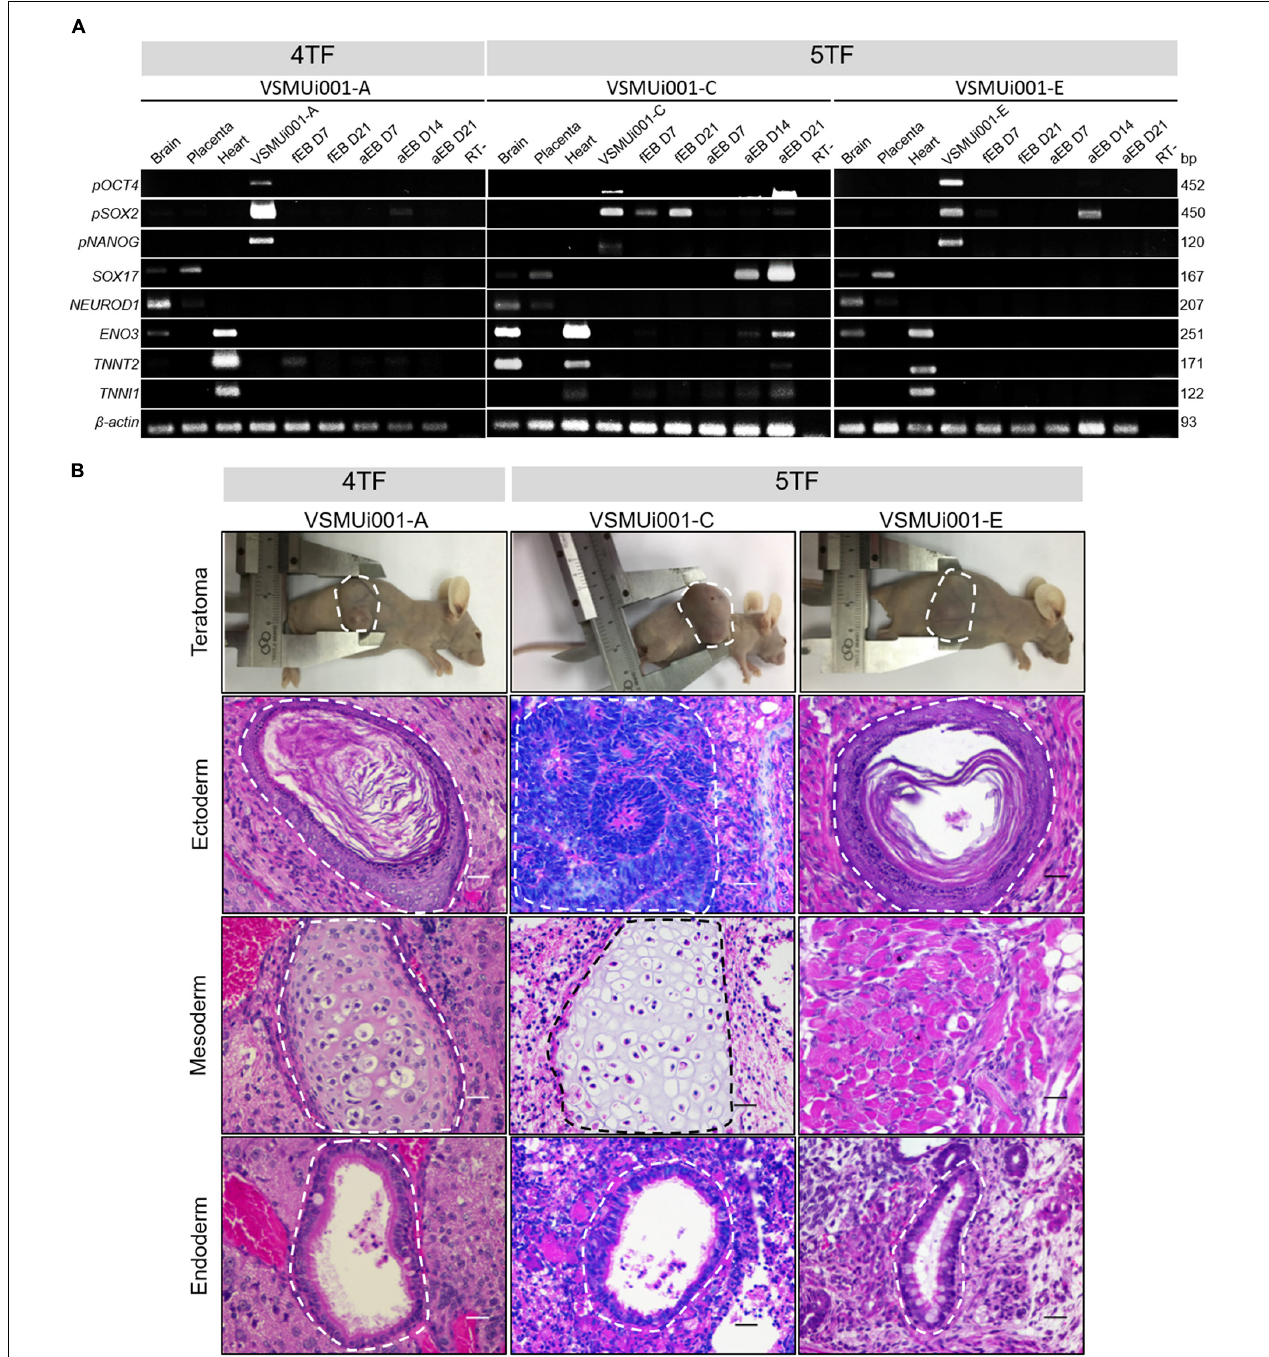
FIGURE 7 | Expression of differentiation-related genes and in vivo differentiation of the various porcine-induced pluripotent stem cell (piPSC) lines. (A) Expression of differentiation genes specific for the three germ layers: pOCT4 , pSOX2 , and pNANOG (pluripotency genes); SOX17 (endoderm); NEUROD1 (ectoderm); and ENO3, TNNT2 and TNNI1 (mesoderm). fEB, floating embryoid body; aEB, adherent embryoid body. (B) Teratoma formation; all nude mice developed teratomas. Hematoxylin and eosin staining of the teratoma section generated by piPSCs showing a broad range of tissues of the three germ layers: keratinized squamous epithelia (VSMUi001-A and VSMUi001-E) and immature neuroepithelia forming rosettes (VSMUi001-C; ectoderm), cartilage (VSMUi001-A and VSMUi001-C), and skeletal muscle (VSMUi001-E; mesoderm), and respiratory-like epithelia (VSMUi001-A, VSMUi001-C, and VSMUi001-E; endoderm); scale bar, 25 µ m. 4TF, induction using OCT4, SOX2, KLF4, and C-MYC; 5TF, induction using OCT4, SOX2, KLF4, C-MYC, and LIN28; pOCT4 , endogenous porcine octamer-binding transcription factor 4; pSOX2 , endogenous porcine SRY-box transcription factor 2; pNANOG , endogenous porcine Nanog homeobox; SOX17, SRY-box transcription factor 17; NEUROD1, neuronal differentiation 1; ENO3, enolase 3; TNNT2 , troponin T2, cardiac type; TNNI1, troponin I1, slow skeletal type.